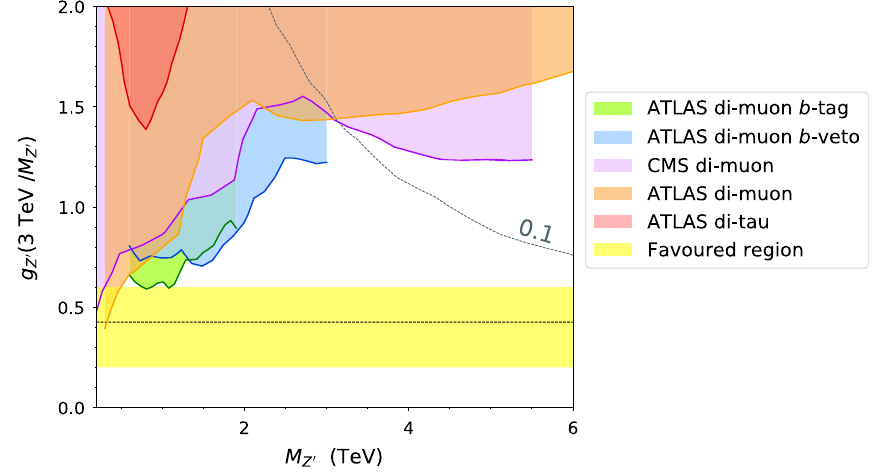
Fig. 16 Summary of the 95% CL excluded regions in the TFHM from theLHC Z (cid:2) searchesconsideredinthiswork.Foreachsearch,theregion excluded to the 95% CL is shown by the coloured region, as according to the legend. The yellow band indicates the region favoured by the flavour and electro-weak data at the 95% CL, and the horizontal dashed